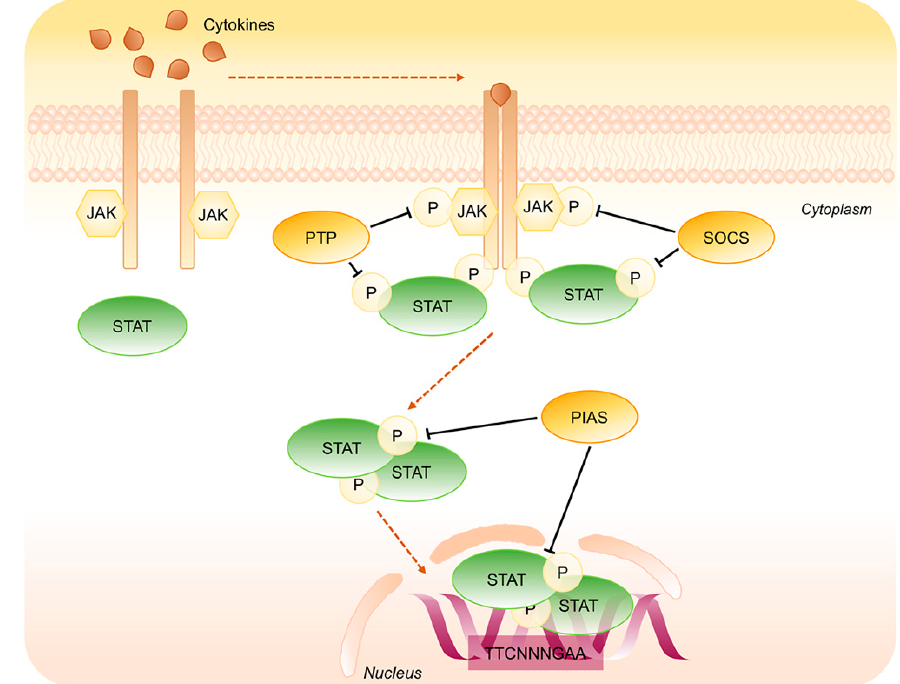
Figure 4. Negative regulation of STAT1 and STAT3 signaling pathway. Key steps of STAT1 / 3 signaling negative regulation. Phosphotyrosine Phosphatases (PTP) and Suppressors of Cytokine Signaling (SOCS) dephosphorylate JAKs as well as STATs in the cytoplasm whereas the Inhibitory Proteins of Activated STATs (PIAS) operate on STATs dimers in the cytoplasm as well as into the nucleus.